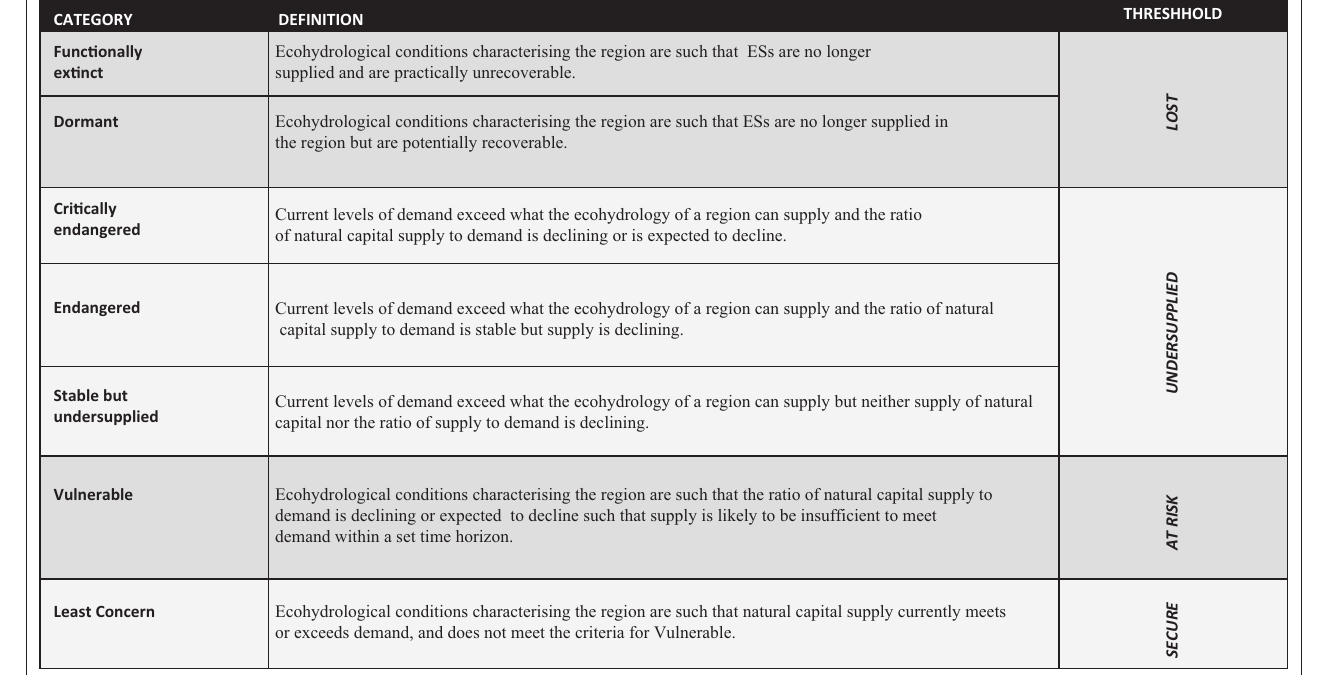
FIGURE 1: A framework to categorise threats to ecosystem